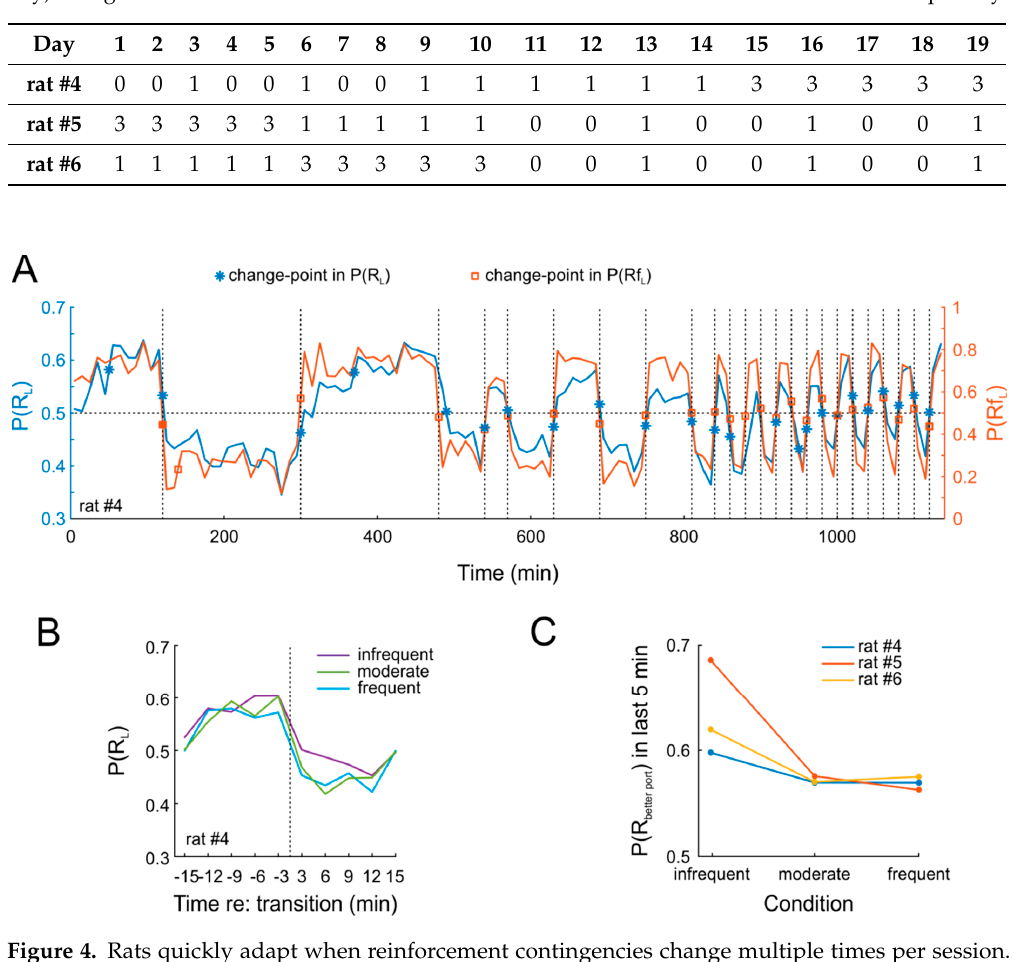
Table 2. The sequence of reward rate changes per experimental session for each of three animals.